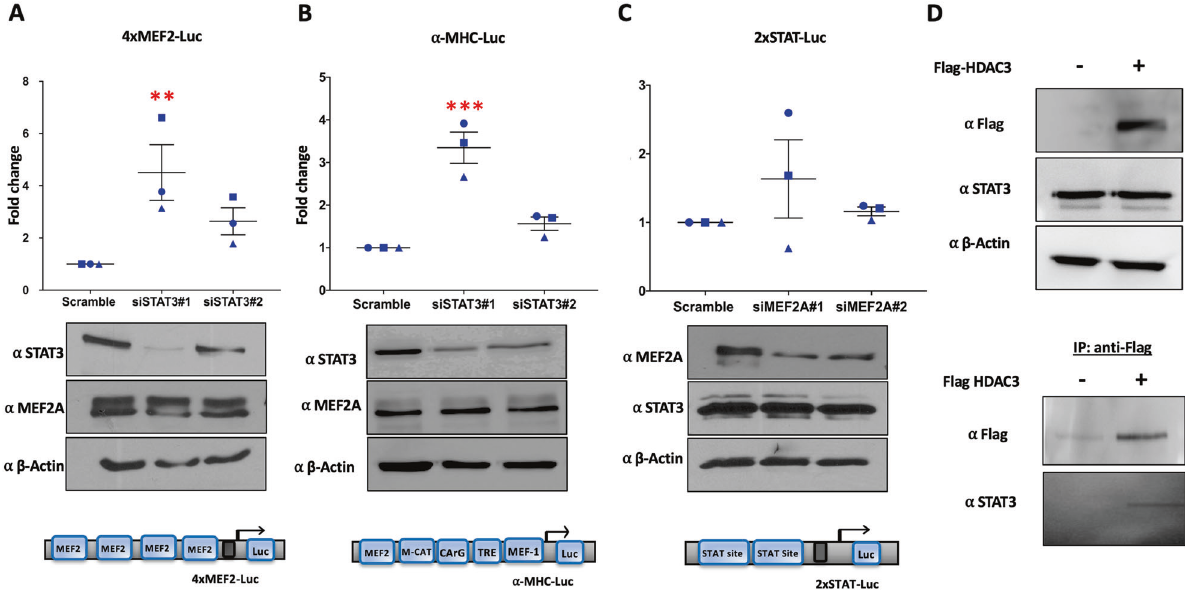
Fig. 4 STAT3 regulates MEF2A-dependent transcription. A PCMs were transfected with a 4xMEF2 luciferase reporter gene along with two independent siRNAs, siSTAT3#1 and #2, to deplete the endogenous STAT3 levels or a scrambled siRNA was used as control. Renilla luciferase was used to normalize for transfection ef fi ciency. Lysates were collected at 48 h. The luciferase activity under each condition was measured and normalized to Renilla values to determine the fold change (Top panel). Corresponding western blot analysis using equal amounts of total protein of the cell lysates were used to con fi rm siRNA mediated STAT3 depletion as compared to scrambled controls (Bottom panel). Number of biological replicates for western blotting was n = 3. A schematic of 4xMEF2A-Luc construct is shown below the luciferase results. B PCMs were transfected with an α -MHC-Luc reporter gene with two independent siRNAs, siSTAT3#1 and #2, or scrambled siRNA as control. Luciferase activity was assessed after 48 h and normalized to Renilla activity (Top panel). Corresponding western blot analysis of cell lysate to con fi rm the depletion of STAT3 protein level as compared to the control is shown (Bottom panel). Number of biological replicates for this analysis was n = 3. Schematic of α -MHC-Luc construct is shown below the luciferase data. C PCMs were transiently transfected with 2xSTAT-Luc reporter gene with two independent siRNAs, siMEF2A#1 and #2, or scrambled siRNA as control. Luciferase activity was assessed after 48 h and normalized to Renilla activity (Top panel). Corresponding western blot analysis of cell lysate to con fi rm the depletion of MEF2A protein level as compared to the control (Bottom panel). Number of biological replicates carried out for western blotting was n = 3. A schematic of the 2xSTAT-Luc construct used is shown below the luciferase data. D PCMs were transiently transfected with a Flag-HDAC3 construct and lysates were assessed for protein expression by Western blotting. Flag-MEF2A lysate was used for IP using α -Flag magnetic beads and the eluates were blotted with anti-Flag and STAT3 antibodies. IP with lysate from non-transfected PCMs were used as negative controls. Number of biological replicates for western blot and IP carried out was n = 3. Each condition in the luciferase reporter assay is compared to the control condition for three independently transfected samples (technical replicates) to determine the fold change. Each dot represents one biological replicate and corresponds to the mean of three technical replicates. The error bars represent standard error of the mean (SEM). Dunnett ’ s multiple comparisons test in one-way analysis of variance using GraphPad Prism 8.0 was used to test for statistical signi fi cance. Adjusted p -value * ≤ 0.05, ** ≤ 0.01, *** ≤ 0.001****<0.0001, comparing to